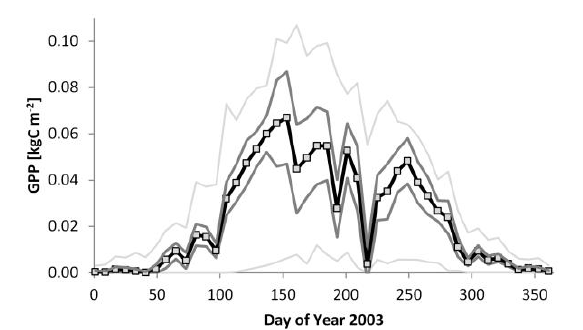
Figure 8. Time series of MODIS-derived GPP of deciduous broadleaf forest in Central Europe in 2003.